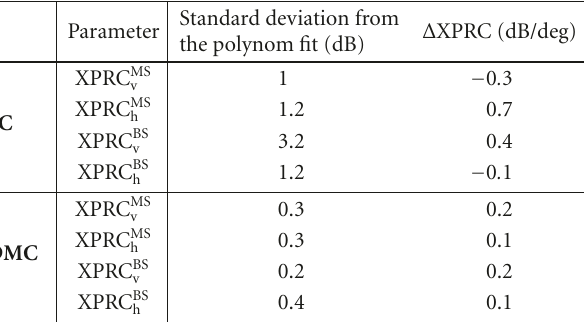
Table 7: Δ XPRC segments Rx19 to Rx27. Standard deviation from Parameter the polynom fit